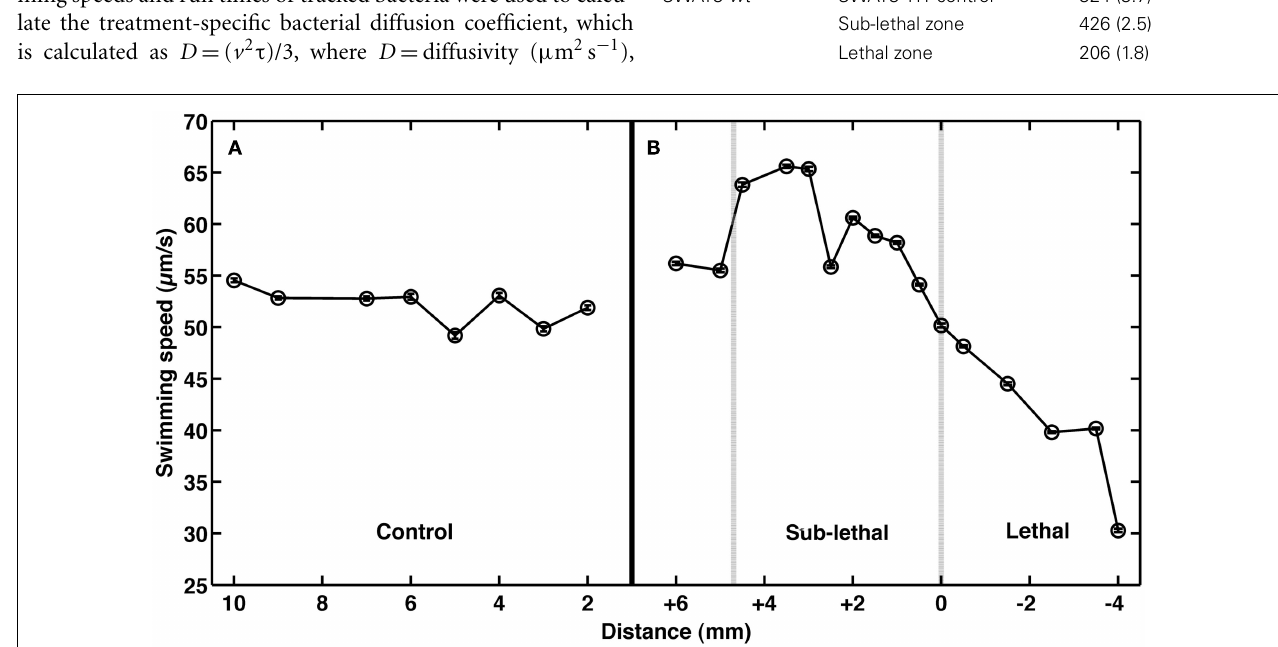
by an andrimid-producing colony of wild-type SWAT3. Swimming speeds increase by > 10% in the sub-lethal zone and decrease upon exposure to lethal concentrations of andrimid. Plotted error bars are contained within data symbols and represent 1 standard error of the